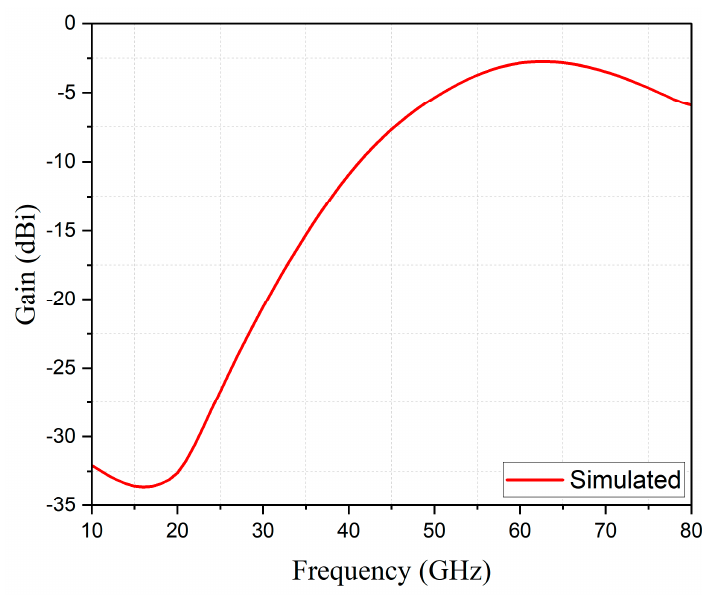
Figure 7. Simulated gain of the antenna.